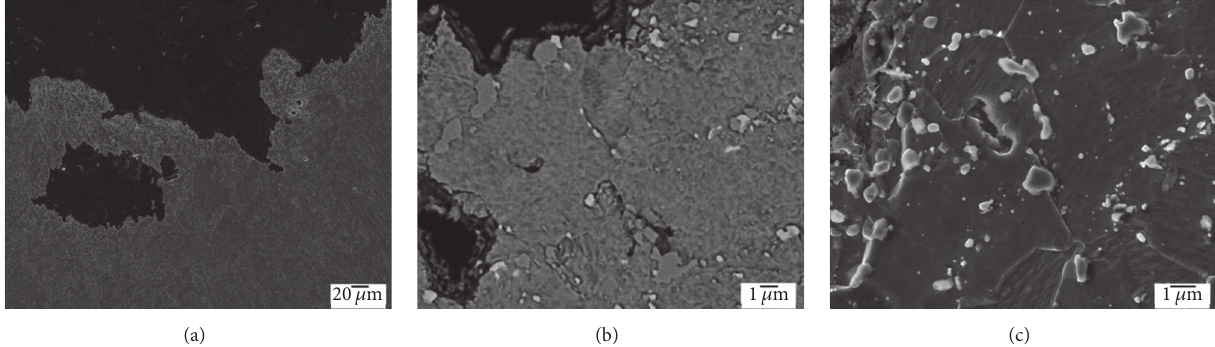
Figure 13: Fracture path (a, b) and creep cavity (b, c) analyses of CB2 weldment ruptured by “type III failure” after the creep test at 625 ∘ C,